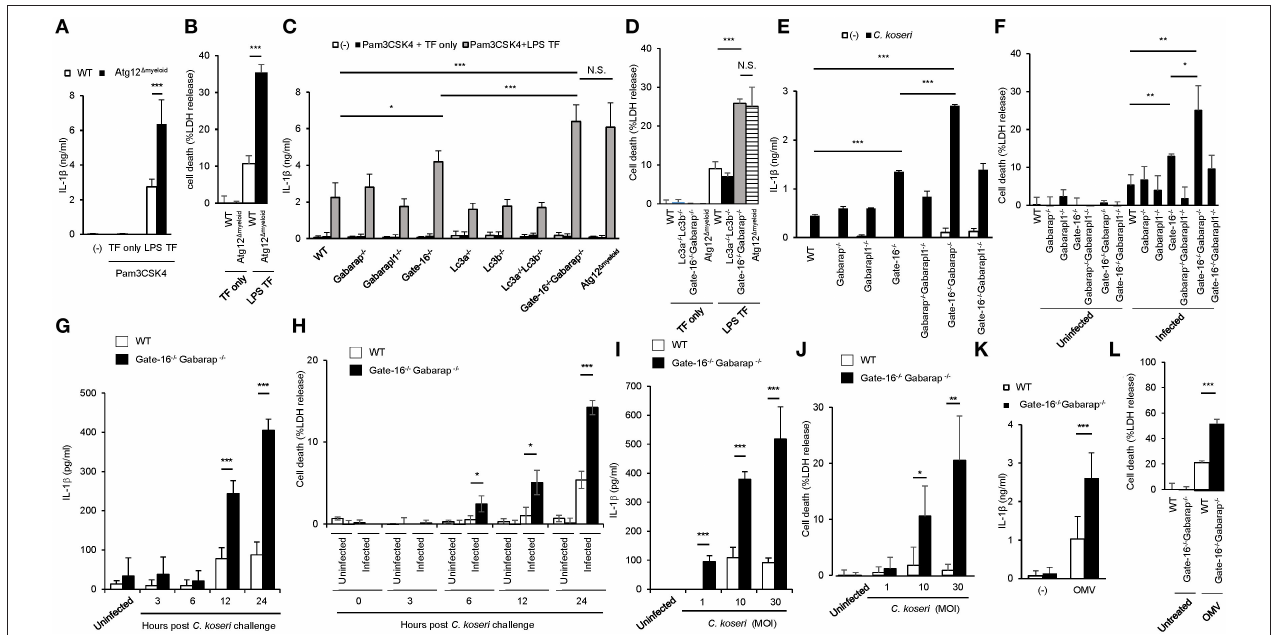
FIGURE 1 | Elevated caspase-11-mediated release of IL- β and pyroptosis in Gate-16 − / − Gabarap − / − macrophages. (A,B) Release of IL-1 β (A) or LDH (B) from wild-type (WT) and Atg12 fl / fl BMDMs primed with Pam3CSK4 followed by LPS transfection for 16h. (C,D) Release of IL-1 β (C) or LDH (D) from wild-type (WT), Atg12 fl / fl , Lc3a − / − , Lc3b − / − , Gate-16 − / − , Gabarap − / − , Gabarapl1 − / − , Lc3a − / − Lc3b − / − , and Gate-16 − / − Gabarap − / − BMDMs primed with Pam3CSK4 followed by LPS transfection for 16h. (E,F) Release of IL-1 β (E) or LDH (F) from wild-type (WT), Gate-16 − / − , Gabarap − / − , Gabarapl1 − / − , Gate-16 − / − Gabarap − / − , Gate-16 − / − Gabarapl1 − / − , and Gabarap − / − Gabarapl1 − / − BMDMs pre-treated with IFN- γ for 24h and subsequently infected with C. koseri for 24h. (G–J) Release of IL-1 β (G,I) or LDH (H,J) from wild-type (WT) and Gate-16 − / − Gabarap − / − BMDMs pre-treated with IFN- γ for 24h and followed by C. koseri infection for indicated hours at MOI (G,H) or for 24h at indicated MOI (I,J) . (K,L) Release of IL-1 β (K) or LDH (L) from wild-type (WT) and Gate-16 − / − Gabarap − / − BMDMs stimulated with OMVs for 16h. The data are combined data of more than three independent experiments. * P < 0.05, ** P < 0.01, *** P < 0.001, and N.S., not significant, two-tailed t